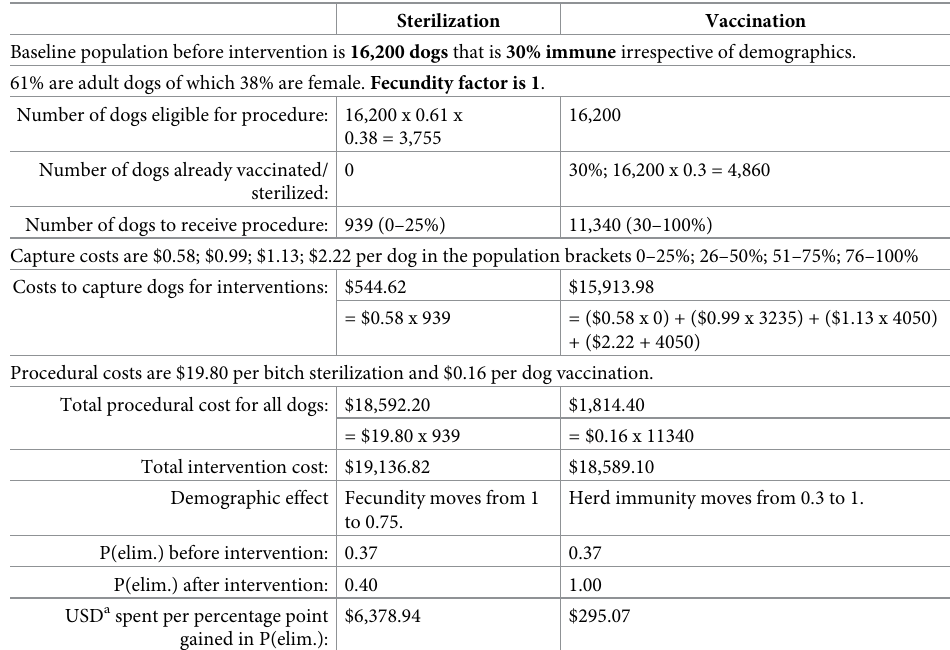
Table 3. Marginal costs to raise P(elim.) through vaccination or sterilization. Sterilization Vaccination Baseline population before intervention is 16,200 dogs that is 30% immune irrespective of demographics. 61% are adult dogs of which 38% are female. Fecundity factor is 1